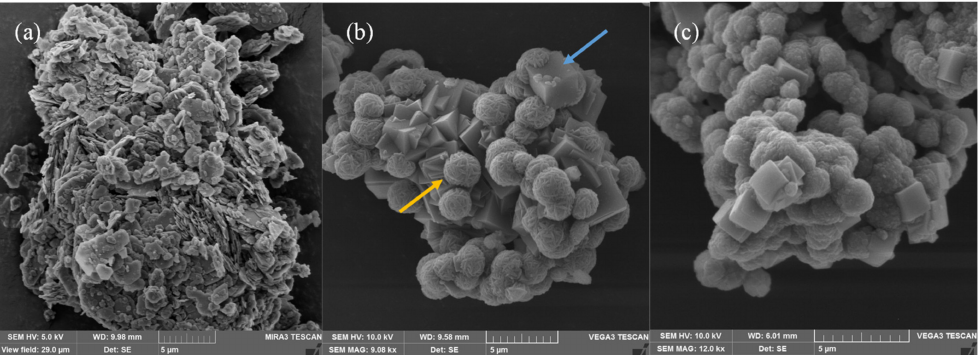
Figure 4. SEM images of zeolite synthesis process. ( a ) metakaolin, ( b ) zeolite after synthesis and ( c ) calcined zeolite.